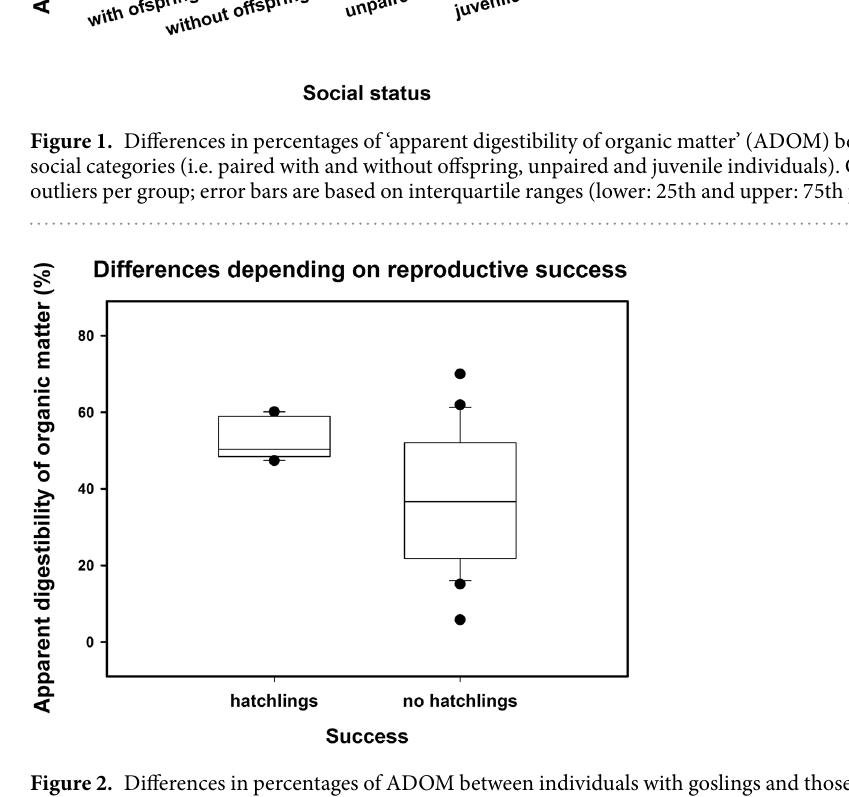
Figure 2. Differences in percentages of ADOM between individuals with goslings and those without goslings in the following season. Circles indicate the outliers per group; error bars are based on interquartile ranges (lower: 25th and upper: 75th